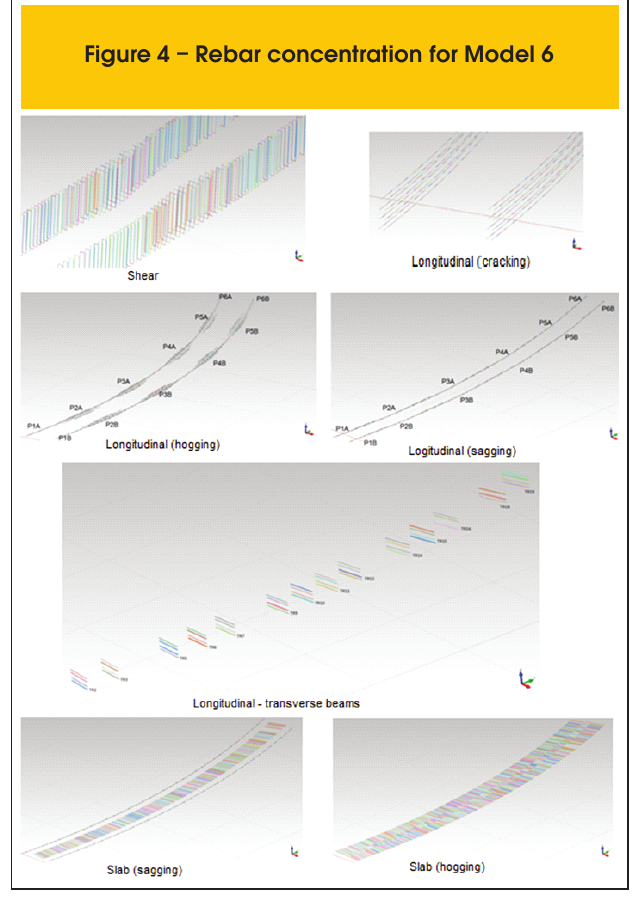
Figure 5 – Concrete's tensile softening diagram (Trautwein